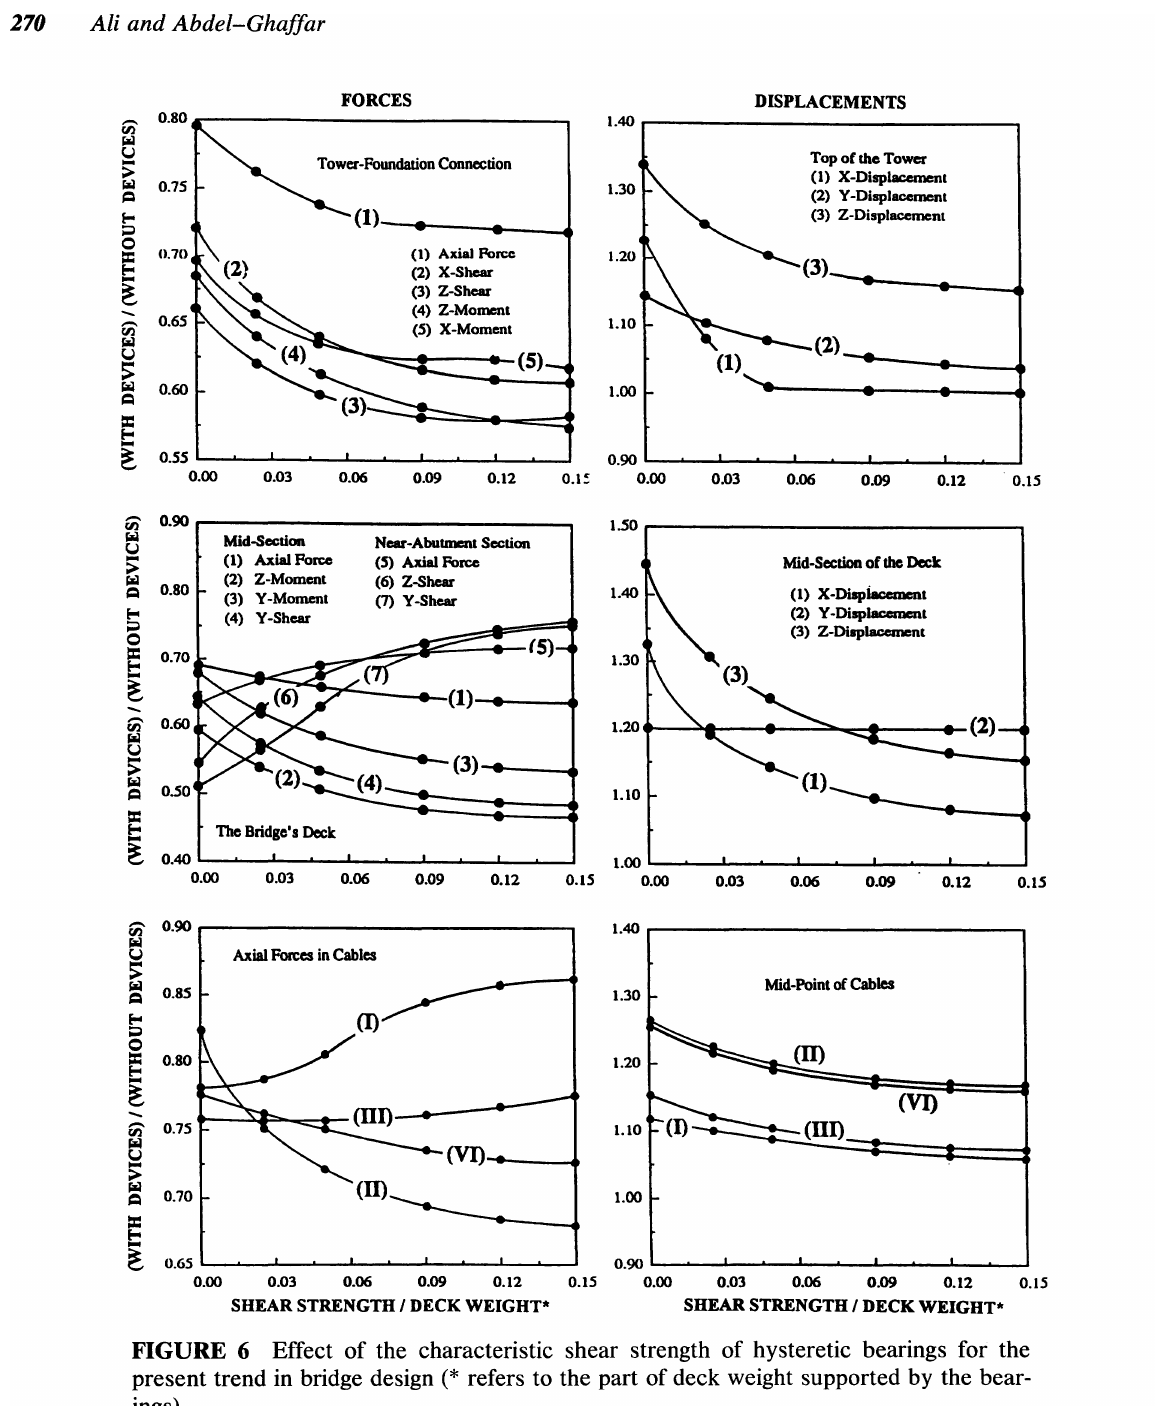
FIGURE 6 Effect of the characteristic shear strength of hysteretic bearings for the present trend in bridge design (* refers to the part of deck weight supported by the bear